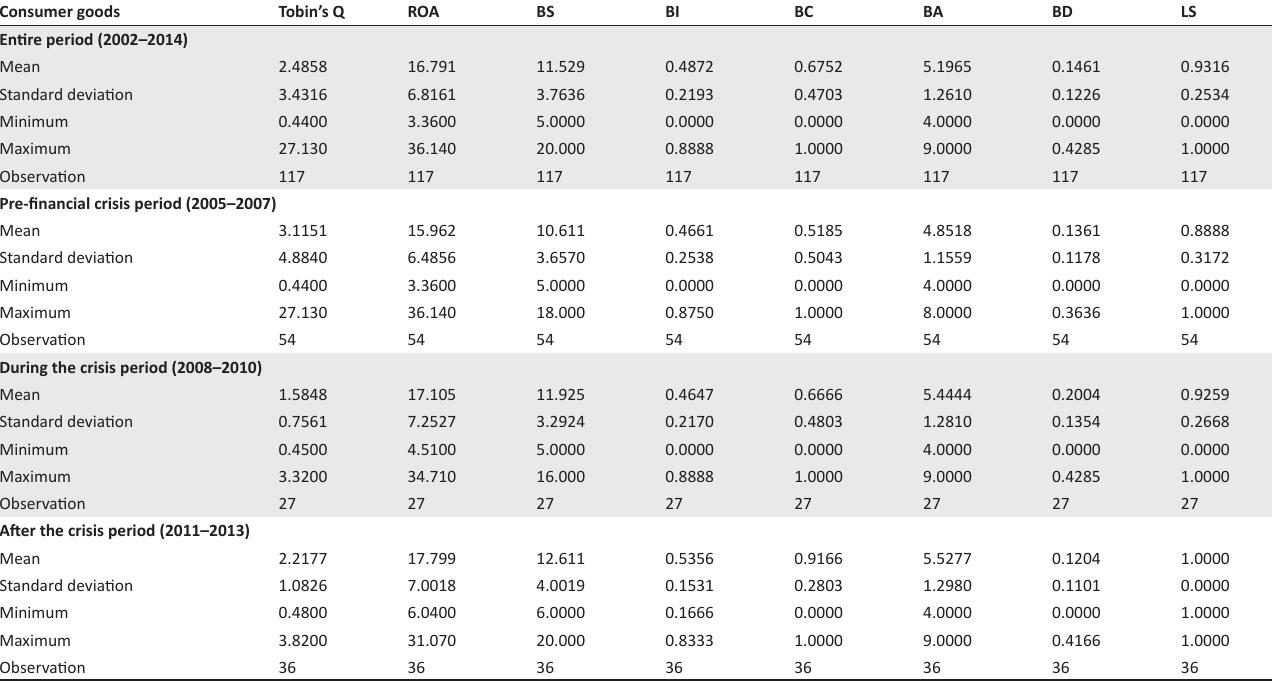
Table 1-A4: Descriptive statistics for the consumer goods